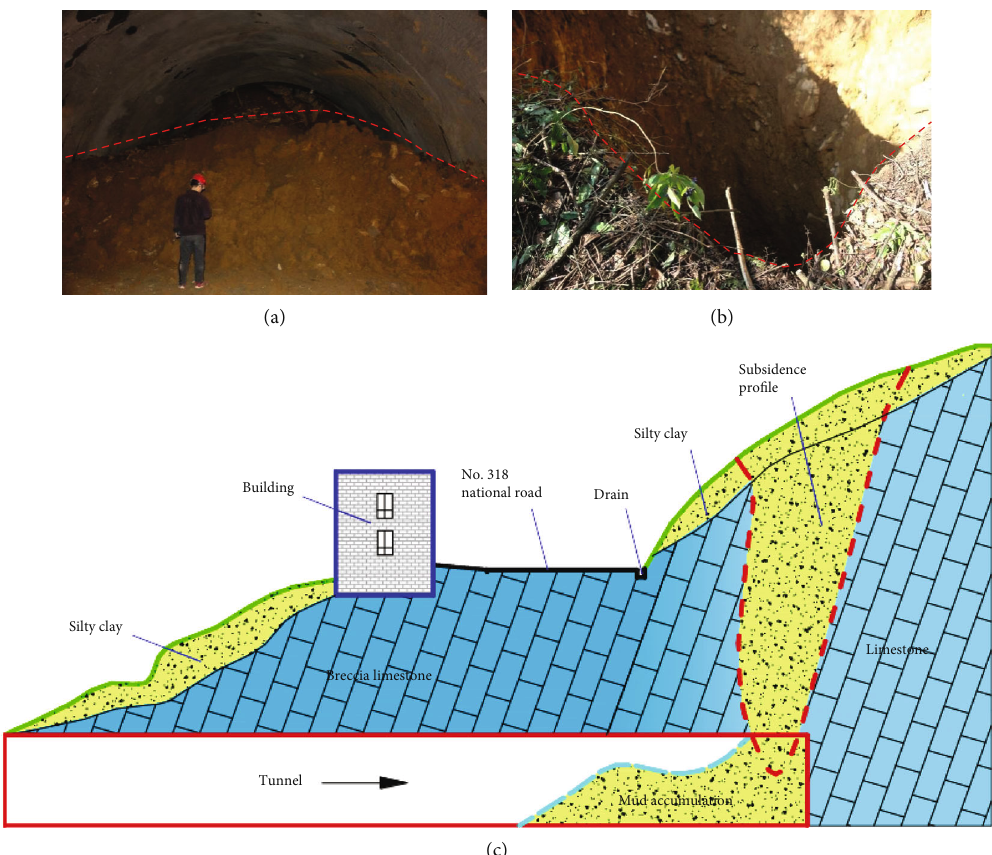
Figure 8: Mud inrush and collapse situation: (a) picture of mud inrush in tunnel; (b) picture of surface subsidence; (c) sketch of mud inrush and